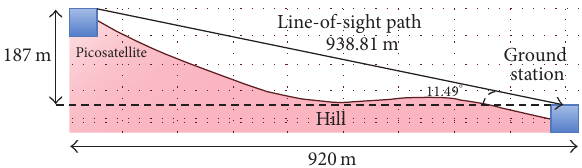
Figure 3: The diagram of the prototype satellite link implemented.